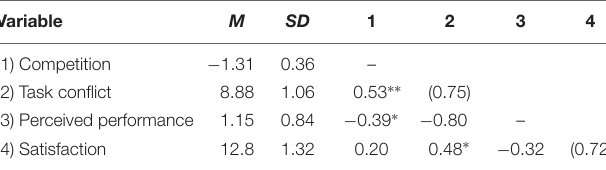
TABLE 1 | Means, standard deviations, correlations, and reliability